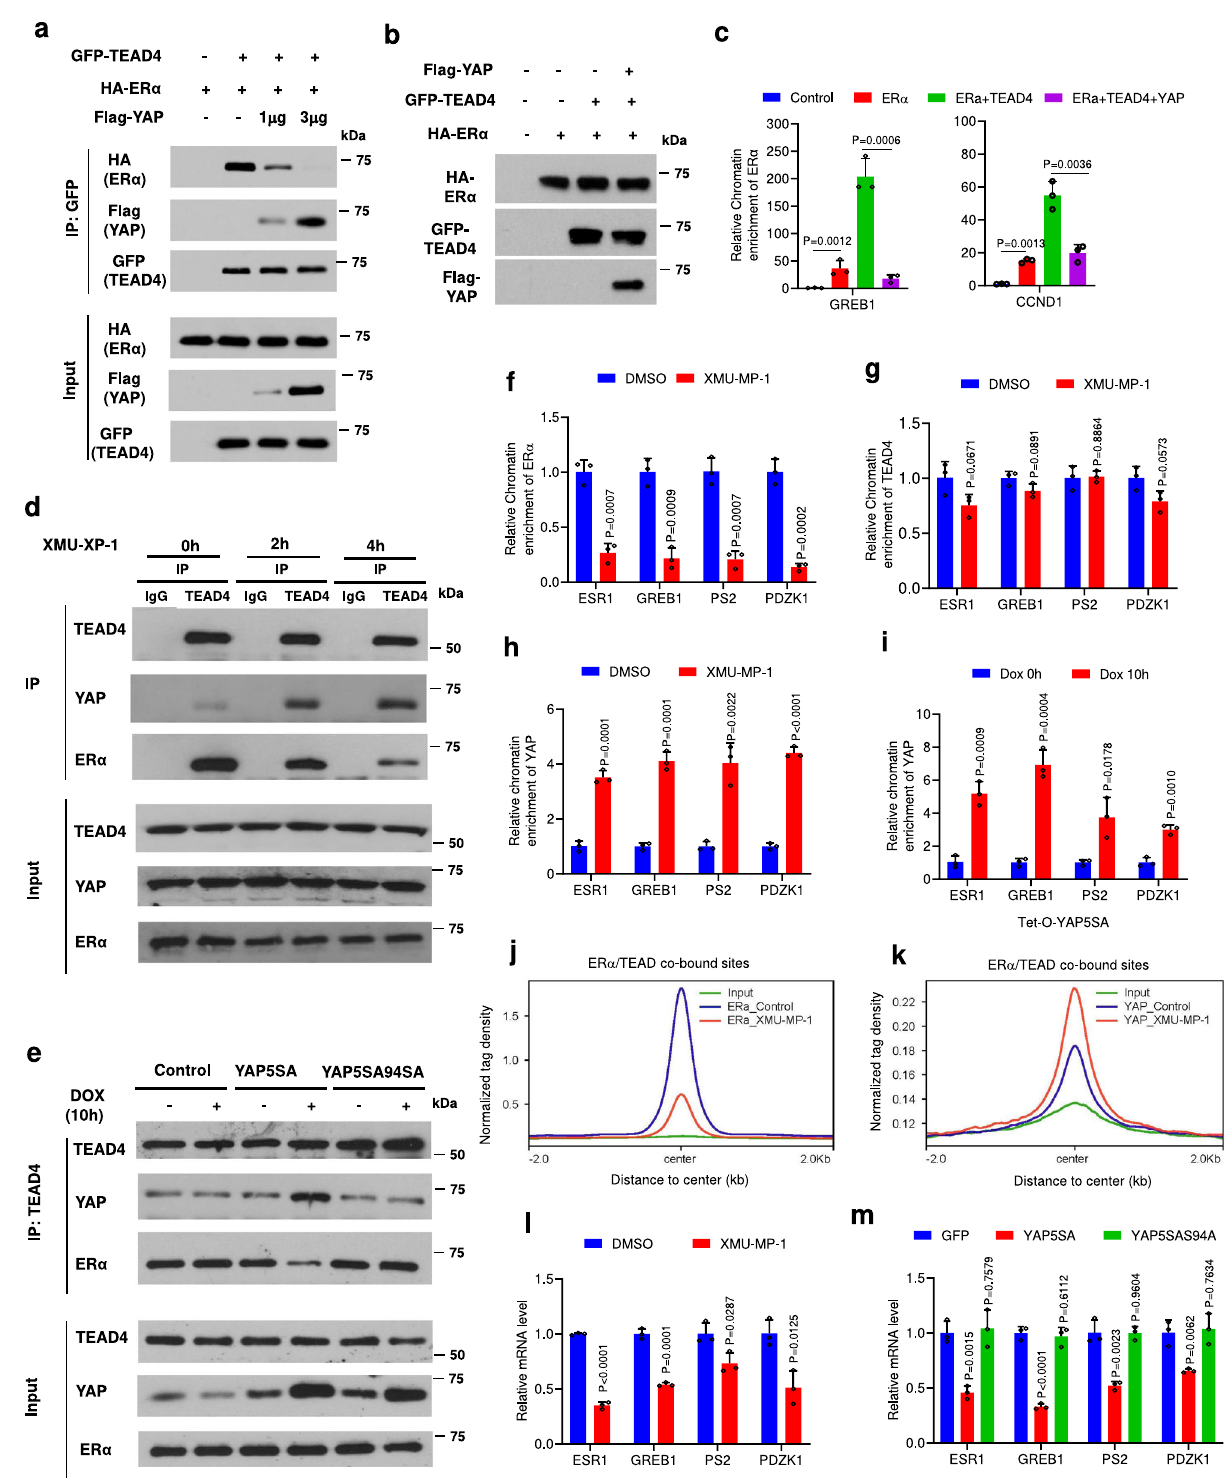
RNA interference . For RNAi experiments in breast cancer cells, the siRNAs were acquired from Sigma – Aldrich. The sequences for YAP silencing were: 5 ’ - CAC CUA sequences for TEAD4 silencing were: 5 ’ - CUC GCU AUG AGA AUG GAC A − 3 ’ and 5 ’ - CAG AGU AUG CUC GCU AUG A − 3 ’ . The sequences for